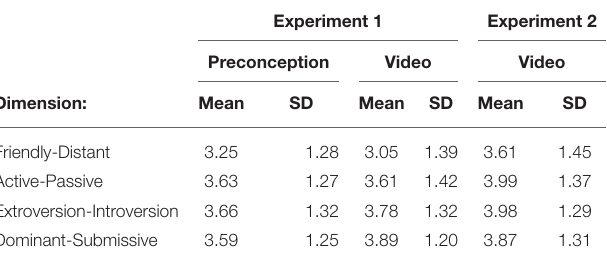
TABLE 1 | Average scores per dimension for experiment 1 and